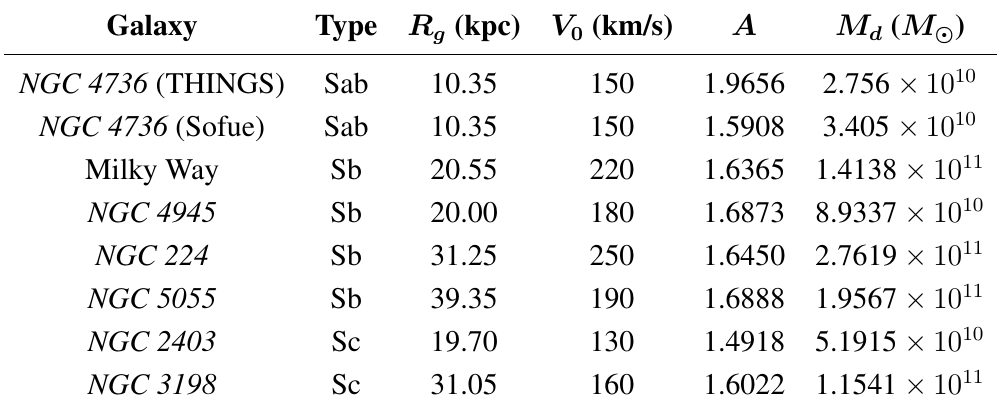
Table 1. Values of R this